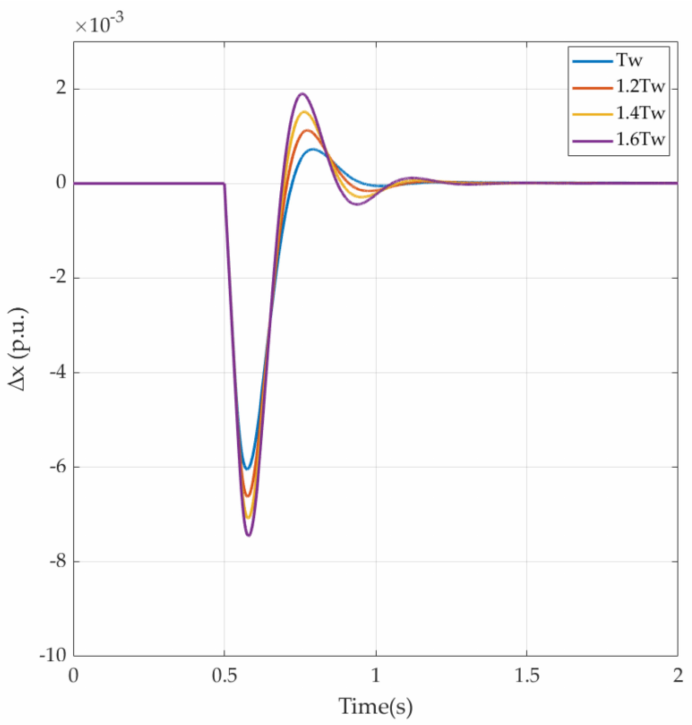
Figure 22. The control effect of the controller when T w changes ( ∆ x − t )